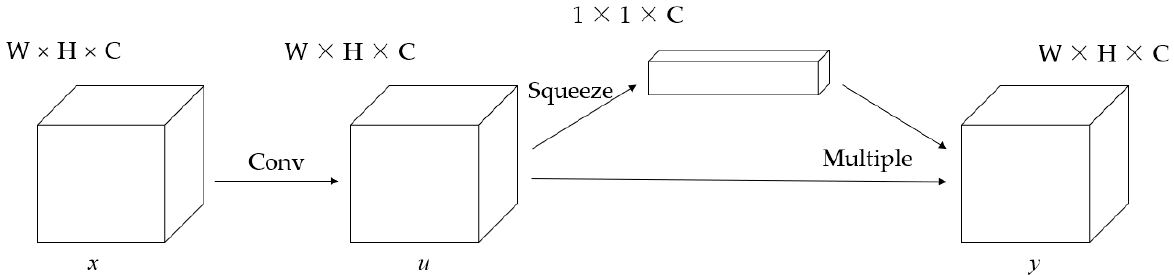
Figure 4. SE unit. W represents the vector width. H represents the vector height. C represents the number of vector channel. The input x is convolved to obtain the feature u . The weight is generated by compressing u into the channel dimension through the squeeze process. Finally, the weighted feature y is obtained by multiplying the weight by the corresponding channel.